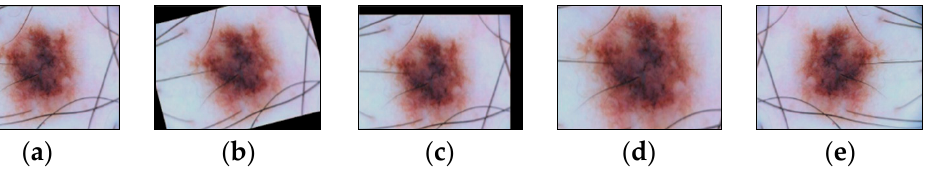
Figure 11. Images obtained as a result of affine transformations: ( a ) original image; ( b ) image after the operation of rotation by a given angle; ( c ) image after shift operation; ( d ) image after the scaling operation; ( e ) image after the reflection operation. Scale bar or magnification.